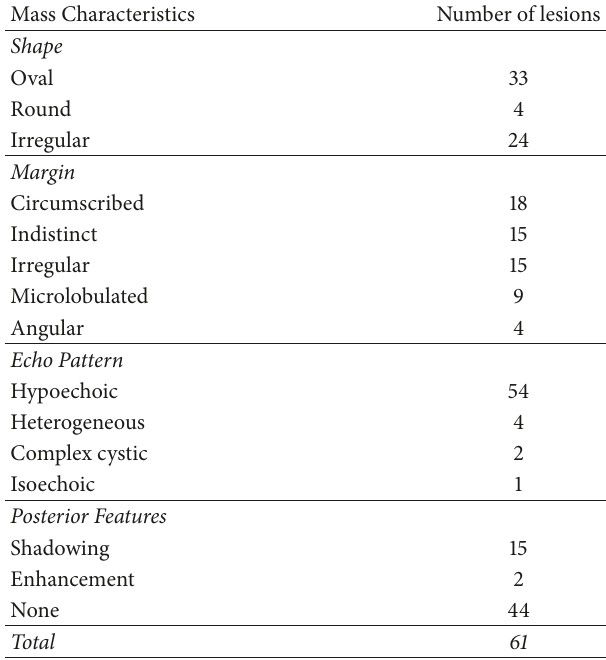
Table 2: Mass characteristics on